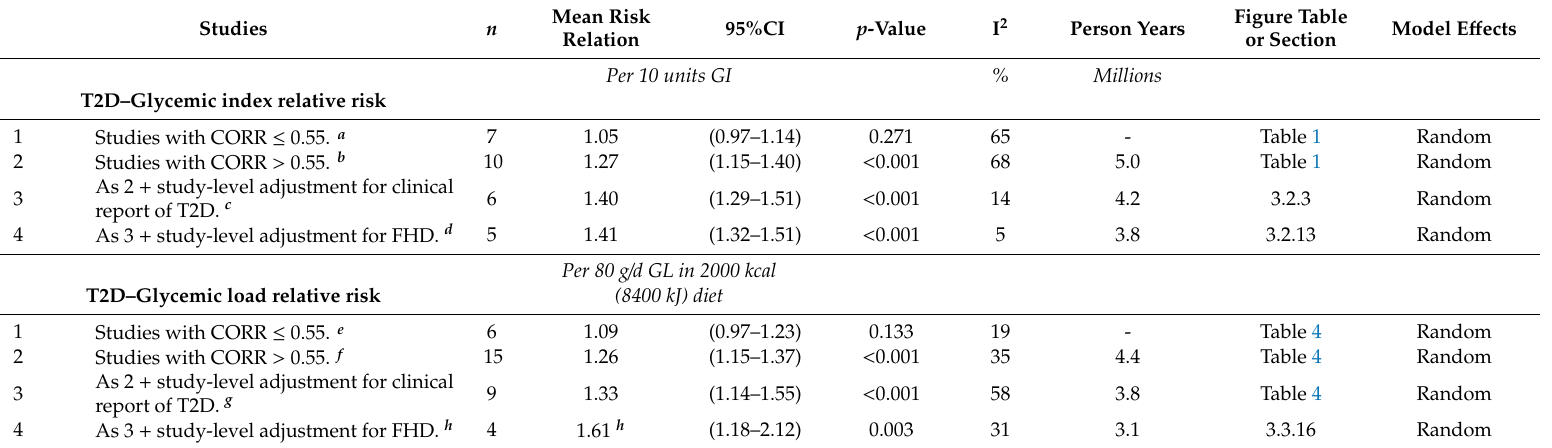
Table 7. Dose response type 2 diabetes–glycemic index and glycemic load risk relations and study-level validity.